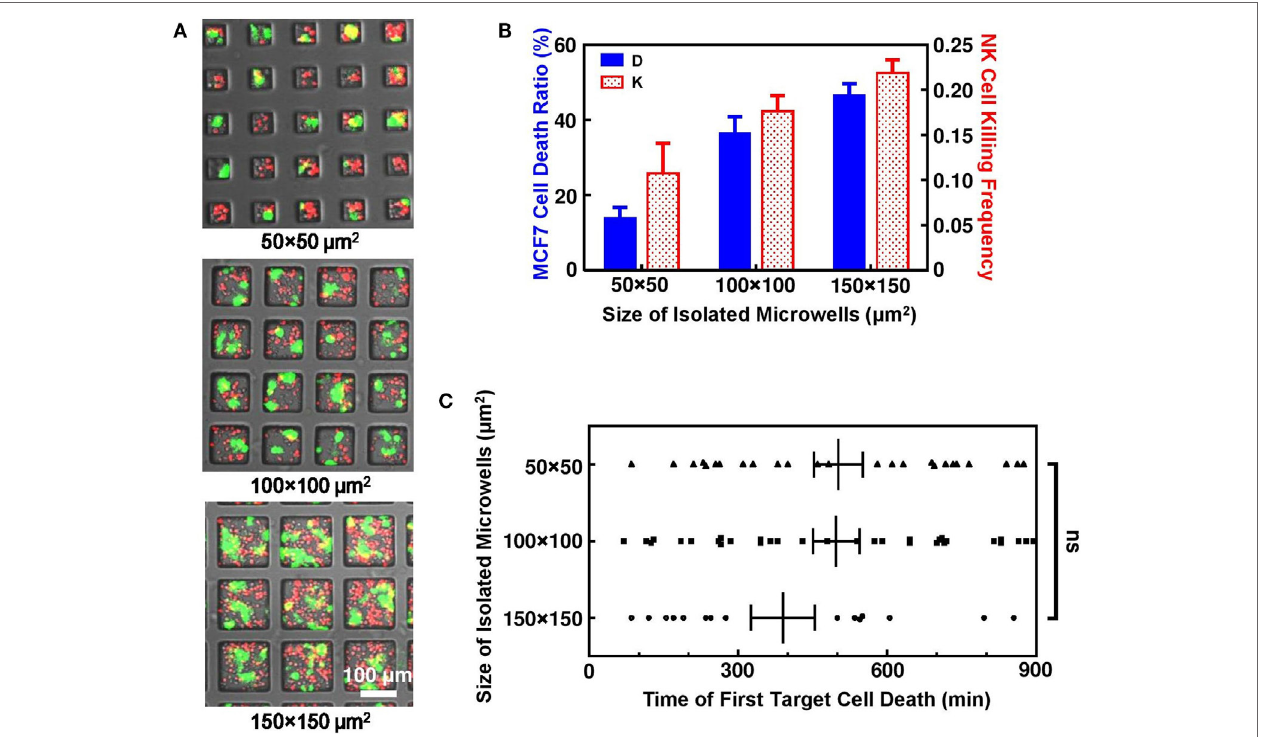
FigUre 2 | Interactions of natural killer (NK) and MCF7 cells in isolated microwells. (a) Microwells of different sizes with NK (red) and MCF7 (green) cells seeded at density of